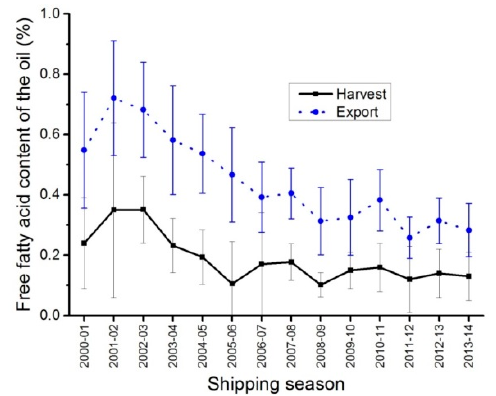
Figure 5. Free fatty acid content of the oil averages, harvest and export samples of Canada No. 1, Canola from 1 August 2000 to 31 July 2014.